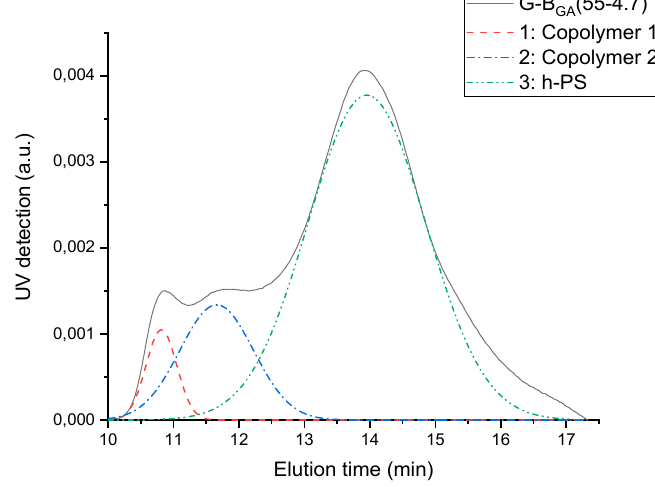
Figure 5. UV elugram of G-B GA (55-4.7) and its deconvolution.